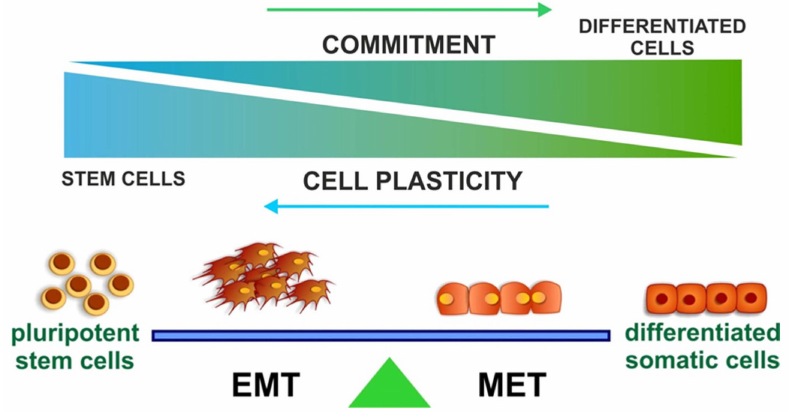
Figure 4. Working model. The balance between Epithelial and Mesenchymal phenotype controls various processes during embryogenesis, development, diseases, and acquisition of